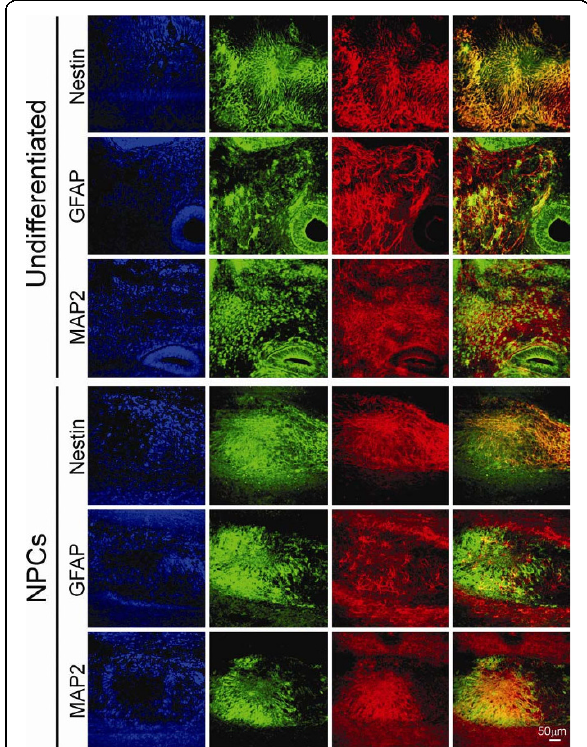
Figure 6 In vivo differentiation of TrES1 . Undifferentiated TrES1 and TrES1 derived NPCs were implanted into contralateral hemispheres of SCID mice for six weeks. Nestin, GFAP and MAP2 were co-expressed with GFP in both hemispheres with the TrES1 graft while homogenous expression pattern was observed at the NPCs implanted hemisphere. First column-DNA staining; Second column-epifluorescent images of GFP; Third column- Immunostaining using specific antibodies; Fourth column-overlay images of second and third column. Scale bar = 50 μ